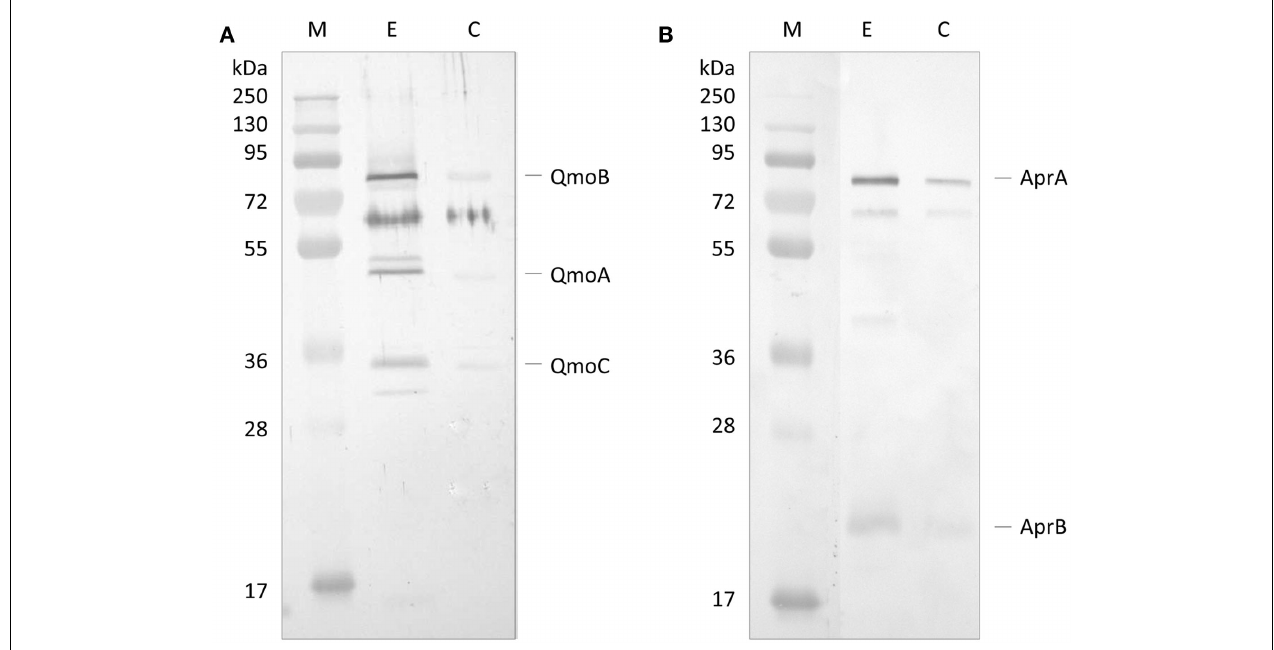
(B) Western Blot with Anti-AprAB of the elution products of: E – the Co-IP using immobilized Anti-QmoABC antibody; C – control resin with no antibody. M – Pre-stained molecular mass